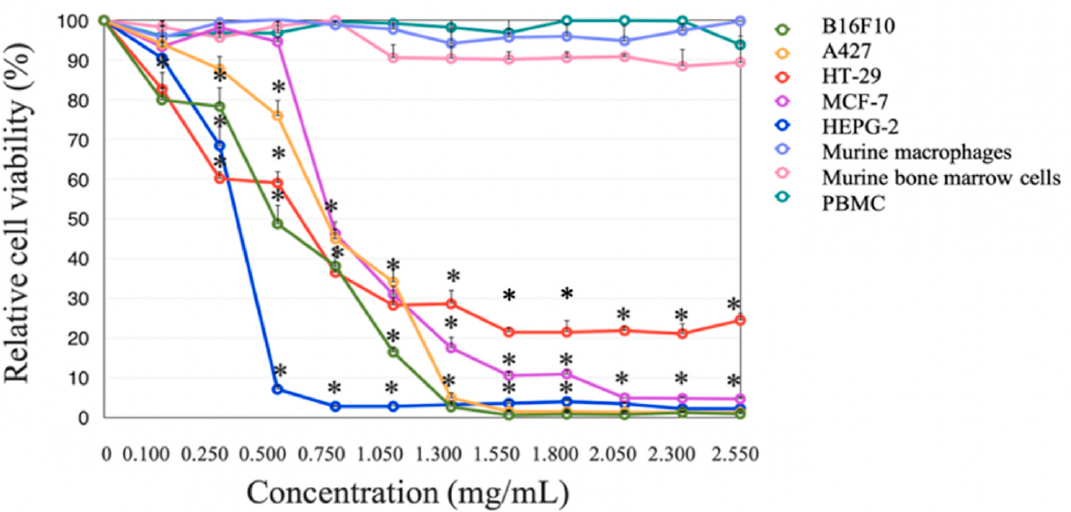
Figure 6. Wet bDLE effect over the viability of B16F10, A427, HT-29, MCF-7, HEPG-2, human PBMC, murine macrophages, and murine bone marrow cells. Cells (5 × 10 3 ) were exposed to wet bDLE in a concentration range from 0.1 to 2.55 mg/mL for 24 h. Cell viability was determined by the MTT assay comparing each cell line or primary culture with the respective untreated control. Statistical significance was determined by one-way ANOVA followed by the Dunnett’s post hoc test (* p < 0.05).